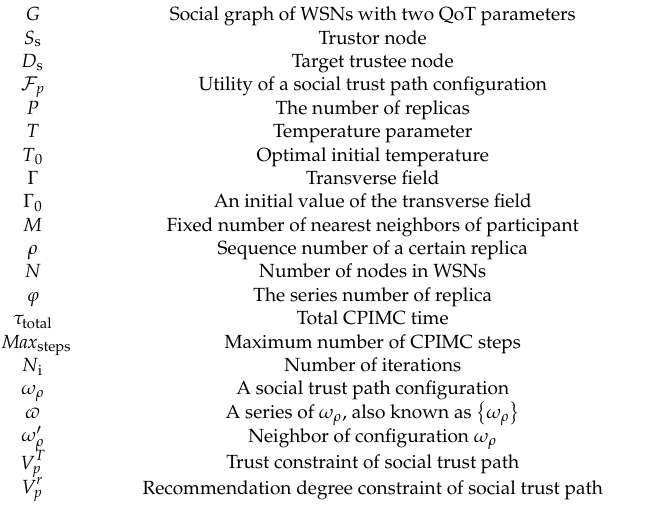
Table 2. Notations used in